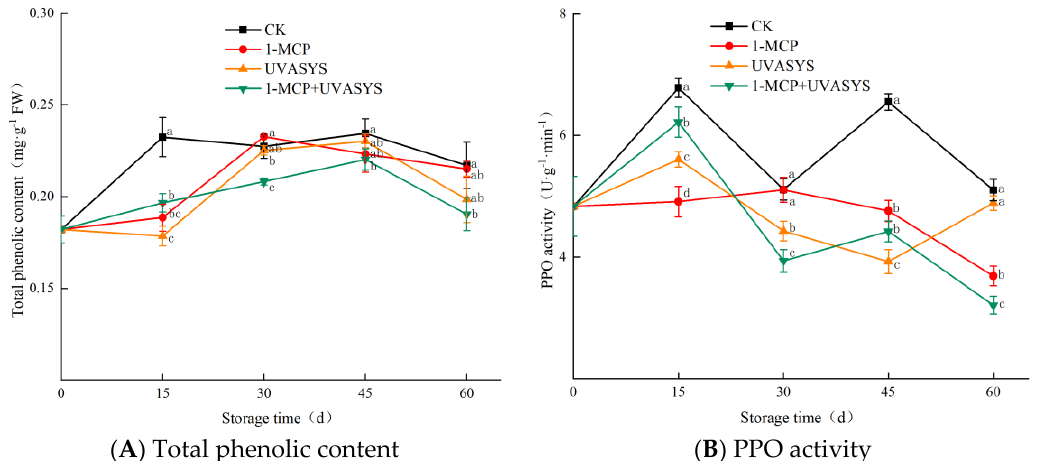
Figure 4. Effects of 1-MCP and UVASYS on total phenol ( A ) and PPO ( B ) of bamboo shoots during storage. Each data point represents an average ± standard error ( n = 3). Different letters indicate significant differences among treatments for each sampling time at p < 0.05.